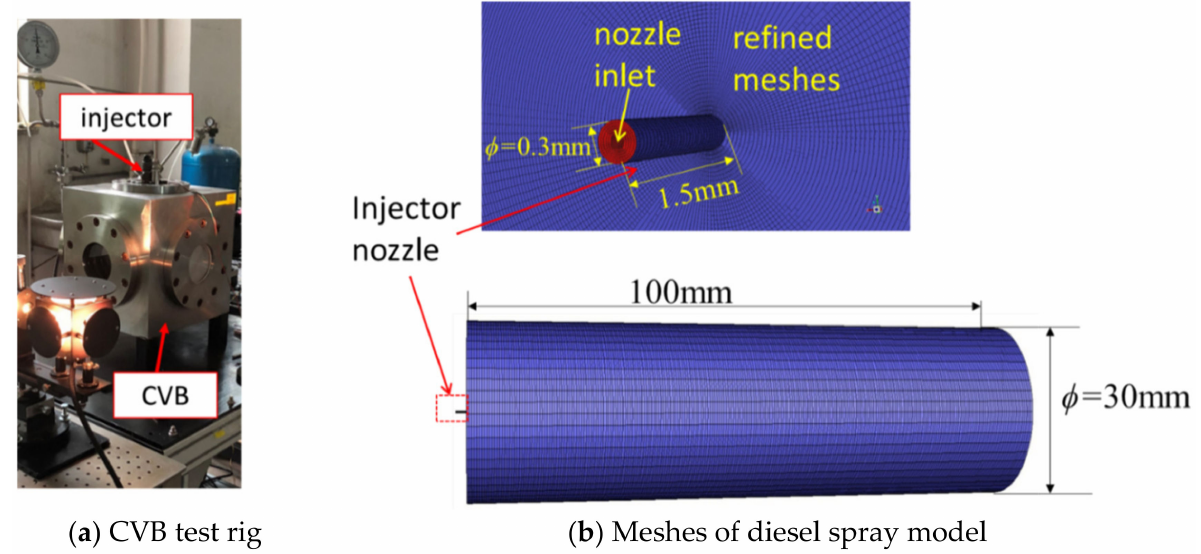
Figure 3. Numerical model of diesel spray in